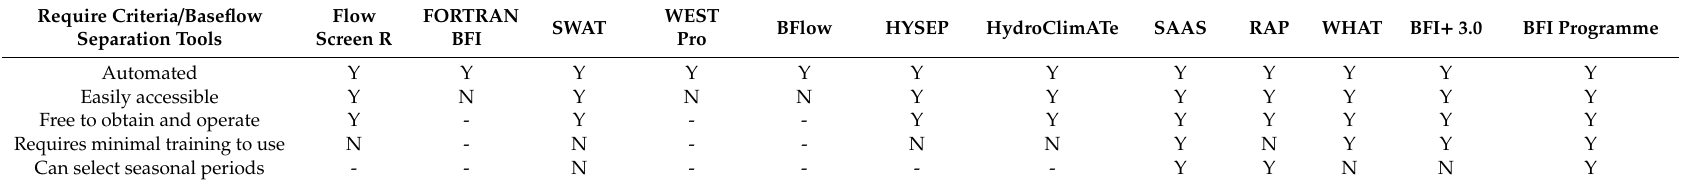
Table 1. Evaluation of baseflow separation tools against required